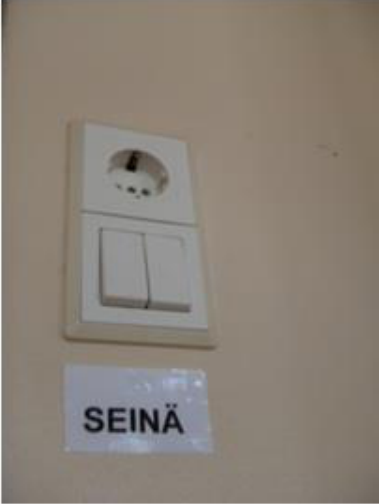
Figure 2. I am able to reach